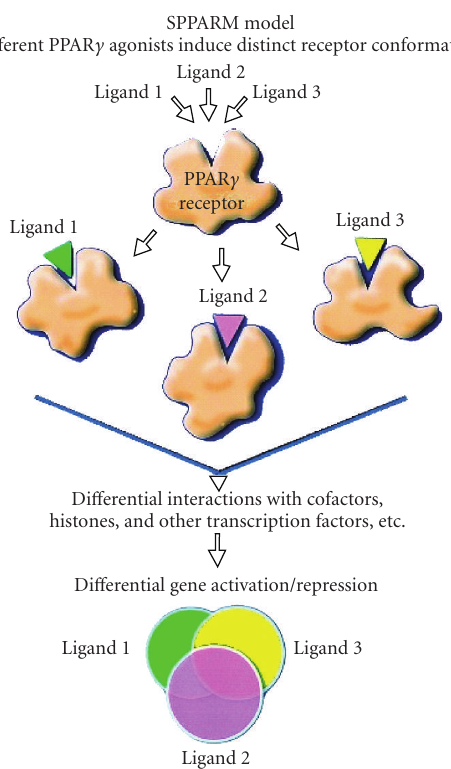
Figure 2: Selective PPAR γ modulator (SPPAR γ M) model of PPAR γ ligand action. PPAR γ is a multivalent receptor whose ligand binding domain can accommodate di ff erent PPAR γ ligands. Ligands 1, 2, or 3 (e.g., full agonist, partial agonist, or SPPAR γ M) are capable of inducing distinct receptor combinations leading to selective gene expression. Each ligand-receptor complex assumes a somewhat di ff erent three-dimensional conformation, leading to unique and di ff erential interactions with cofactors, histones (acetylases/deacetylases), and other transcription factors. Conse- quently, each PPAR γ ligand-receptor complex leads to a di ff erential, but overlapping, pattern of gene expression. Thus, each ligand will activate, or repress multiple genes leading to di ff erential overlapping expression of di ff erent sets of genes. (Adapted with permission from: J. M. Olefsky, “Treatment of insulin resistance with peroxisome proliferator-activated receptor gamma